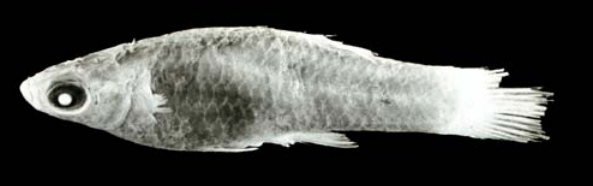
Fig. 4. Phalloptychus eigenmanni . FMNH 55876, rio Catu, Alagoinhas, Bahia, Brazil, holotype, female, 22.8 mm